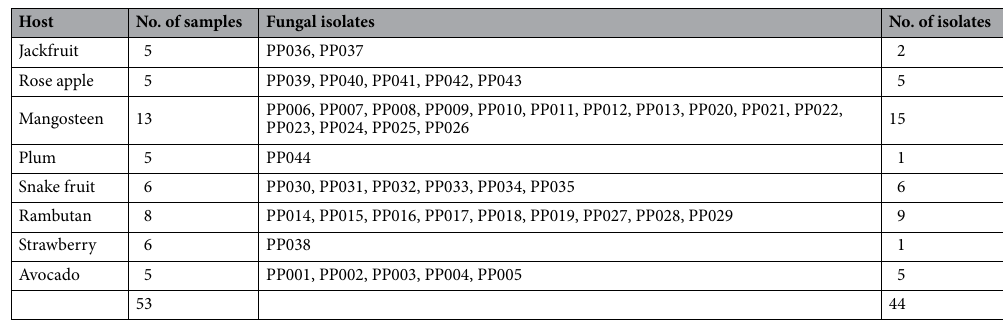
Table 1. Numbers of fruit diseases and fungal isolates in this